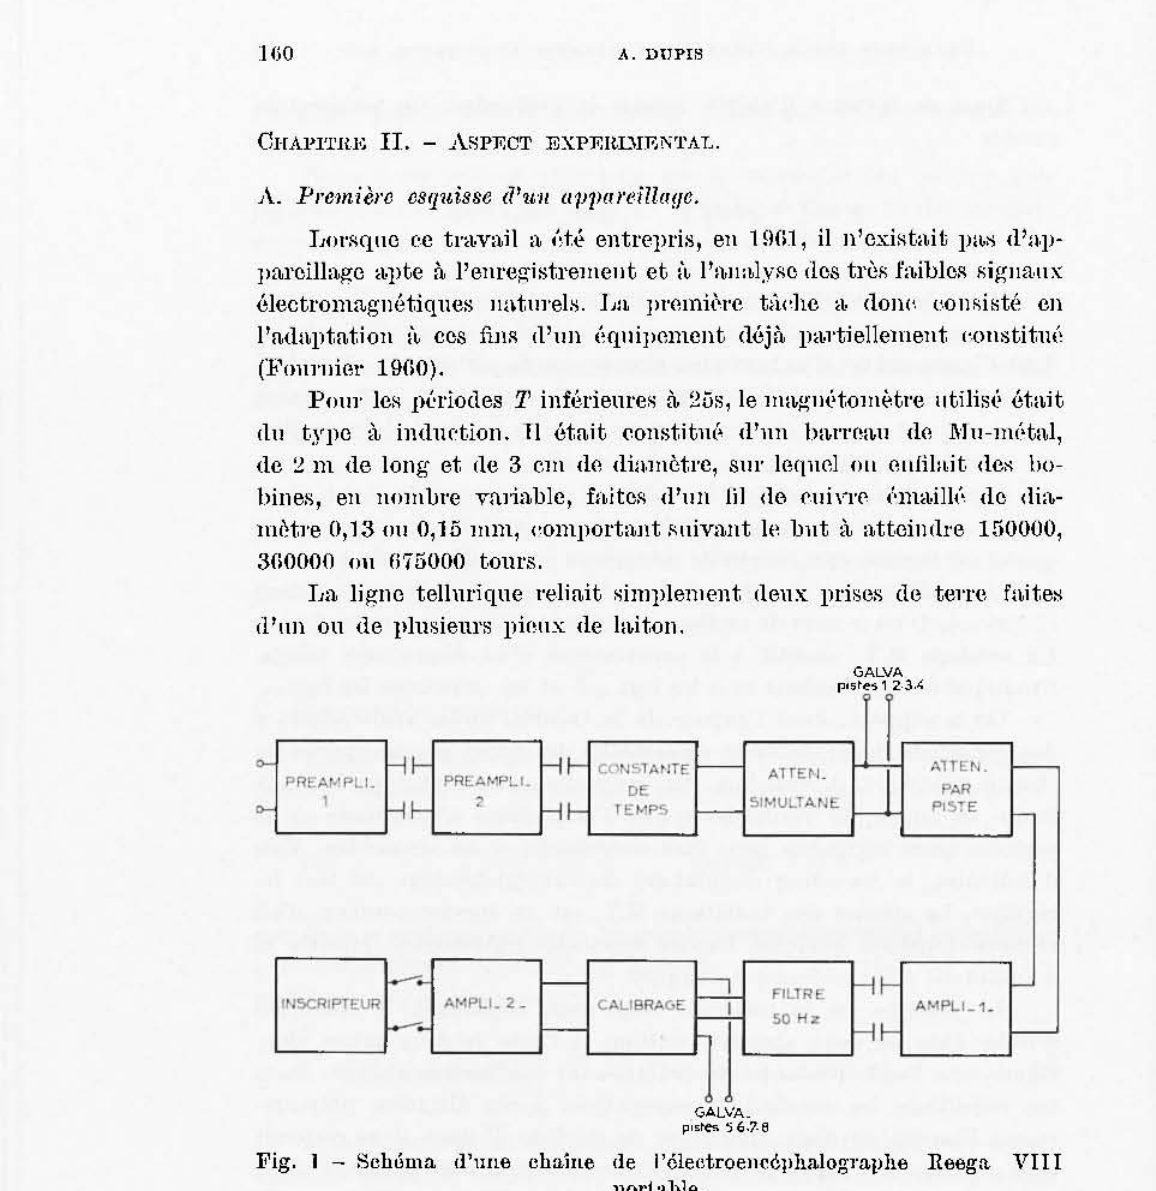
Fig. l - Schuma d'une chaine de l'éleetroellcéphalographe Reega VIII